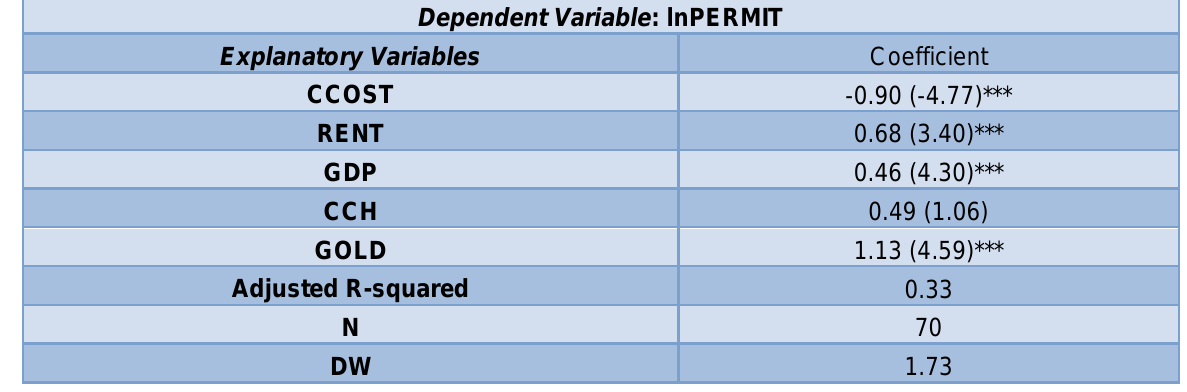
Table 4 Cointegrating Regression (FMOLS